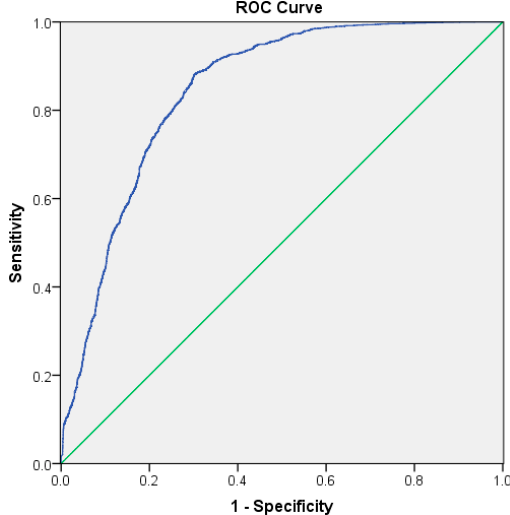
Figure 3. The receiver operator characteristic (ROC) curve of the fire climate index model. Table 3. Pearson correlation of the number of fire occurrences and fire climate index.